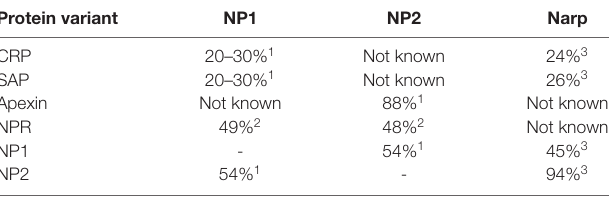
TABLE 1 | Relative amino acid homologies among the pentraxin family. Protein variant NP1